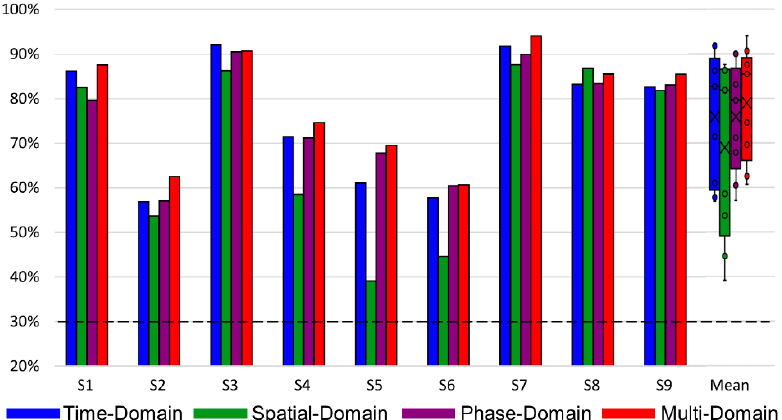
Figure 4. Classification accuracy of the MD-CNN for each domain and subject in the BCI Competition IV dataset 2a: time-domain (blue), spatial-domain (green), phase-domain (purple), and multi-domain representation (red). The box plots with scatter points depict the mean value and distribution for each domain. The horizontal dotted line indicates the chance level.